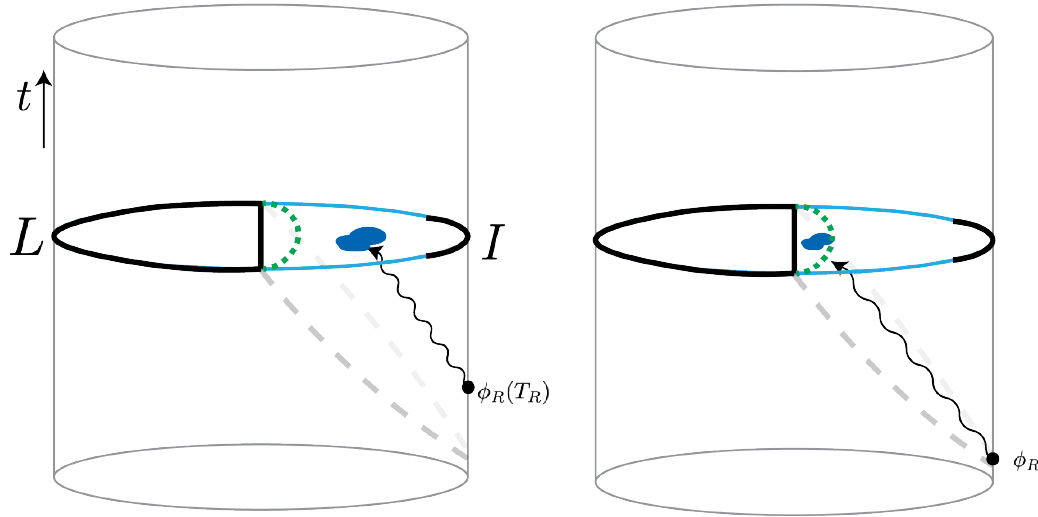
Figure 2 . As we evolve the particle back in time, eventually it will pass from the entanglement wedge of r to the entanglement wedge of LI